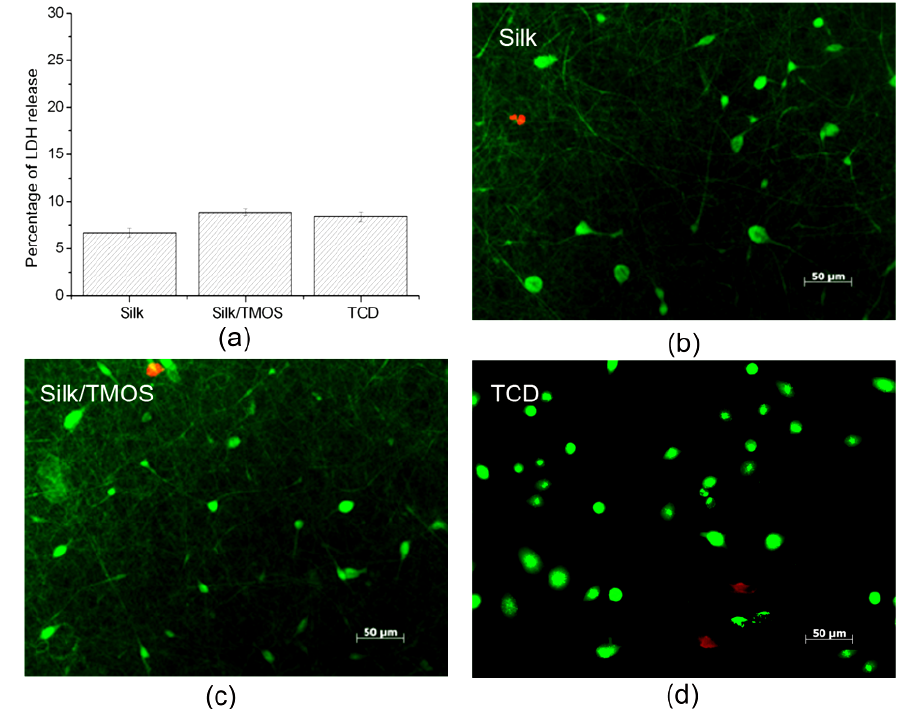
Figure 5. Lactate dehydrogenase (LDH) release ( a ) and fluorescence micrographs of Calcein AM/PI-stained L929 cells with live cells fluorescing green and dead cells fluorescing red after 12 h culture on the Silk/TMOS; ( b ) silk; ( c ) nanofibrous scaffold; and TCD ( d